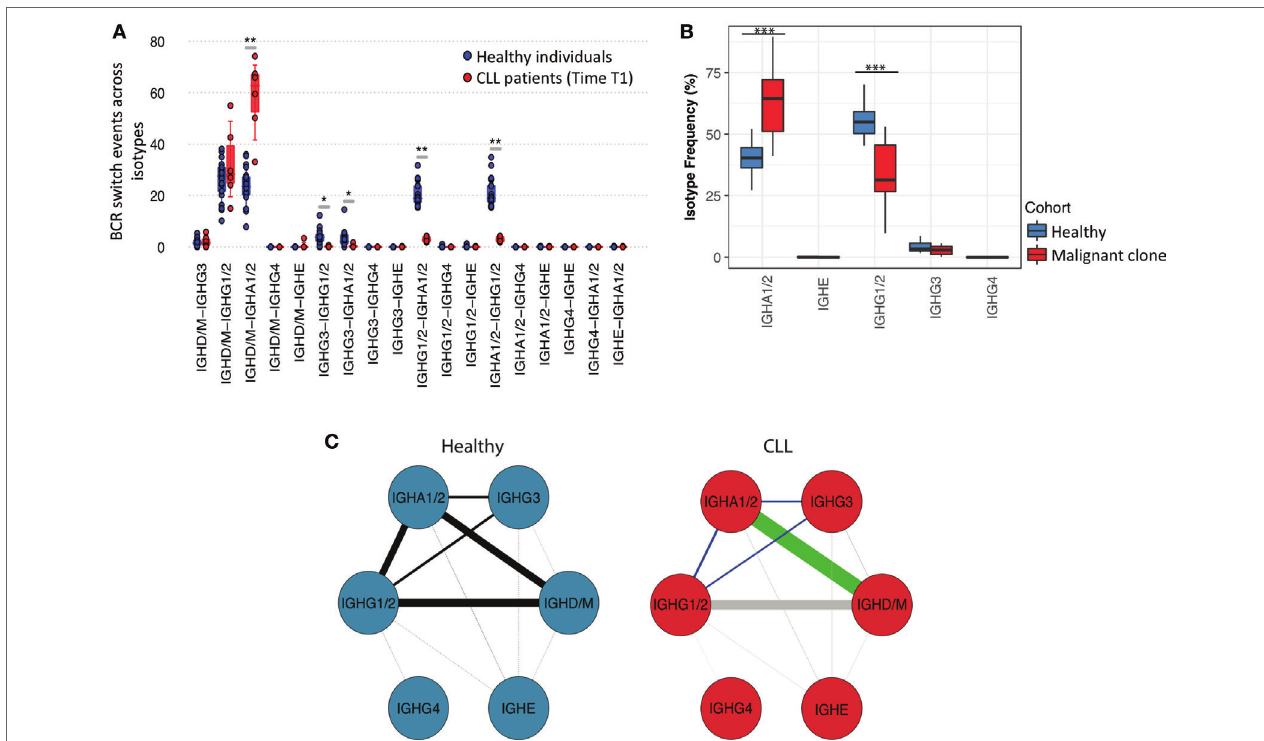
FigUre 4 | Sequential class-switching and isotype co-evolution in healthy and in malignant B-cell clones. (a) Boxplots of the proportion of observed class-switch events [B-cell receptor (BCRs) with identical IGHV-D-J regions but different isotypes] between isotypes for healthy individuals and CLL patients. This was calculated as the number of unique BCRs shared between any two isotypes after accounting for read depth through subsampling (see Materials and Methods), normalized to the total number of events. (B) Relative proportional frequencies of different isotype classes in healthy repertoires and in malignant clones across CLL patients. Malignant clones were derived for each CLL sample by removing the non-malignant component of the repertoire (i.e., the BCRs with VJ genes and complementarity determining region 3 amino acid regions different from the most frequent BCR per sample) from the total CLL repertoire. (c) Representative networks of the relative class-switch event frequencies between pairs of isotypes calculated as described in (a) . The thickness of the lines represents the mean relative class-switch event frequencies calculated as in (a) , and the green and light blue lines connect isotypes that exhibit significantly higher (green) or lower (light blue) overlap probability in CLL repertoires. The gray lines in the “CLL” panel represent combinations of isotypes with non-significant ( p -value > 0.05) difference in the frequency of class-switch events compared to healthy